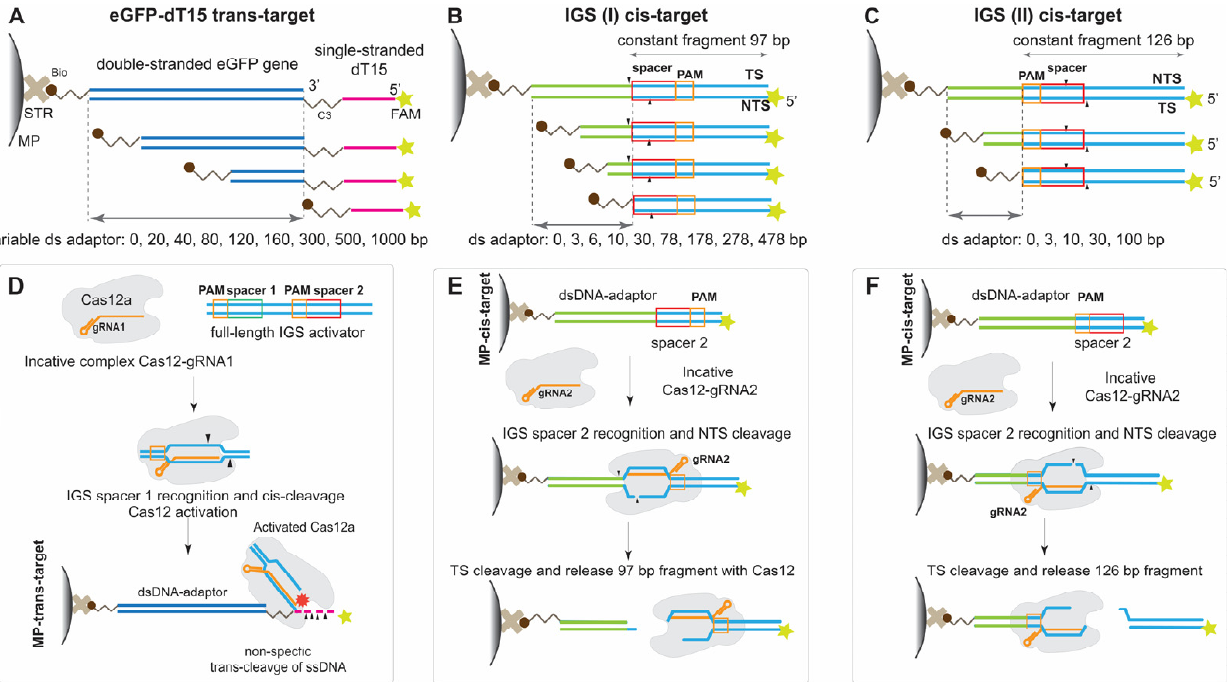
Figure 1. Scheme of experiments. ( A ) Biotin–dsDNA–ssDNA–FAM probe set (trans-target). ( B ) First group (IGS(I)) of cis-target constructs with a sequential arrangement of PAM, spacer, adaptor for attachment to the MP surface. ( C ) Second group (IGS(II)) of cis-target constructs with a sequential arrangement of the spacer, PAM, adaptor for attachment to the MP surface. ( D ) Trans-cleavage of the trans-target. ( E ) Cis-cleavage of the cis-target from the first group. ( F ) Cis-cleavage of cis-target from the second group. MP—magnetic particles, STR—streptavidin.